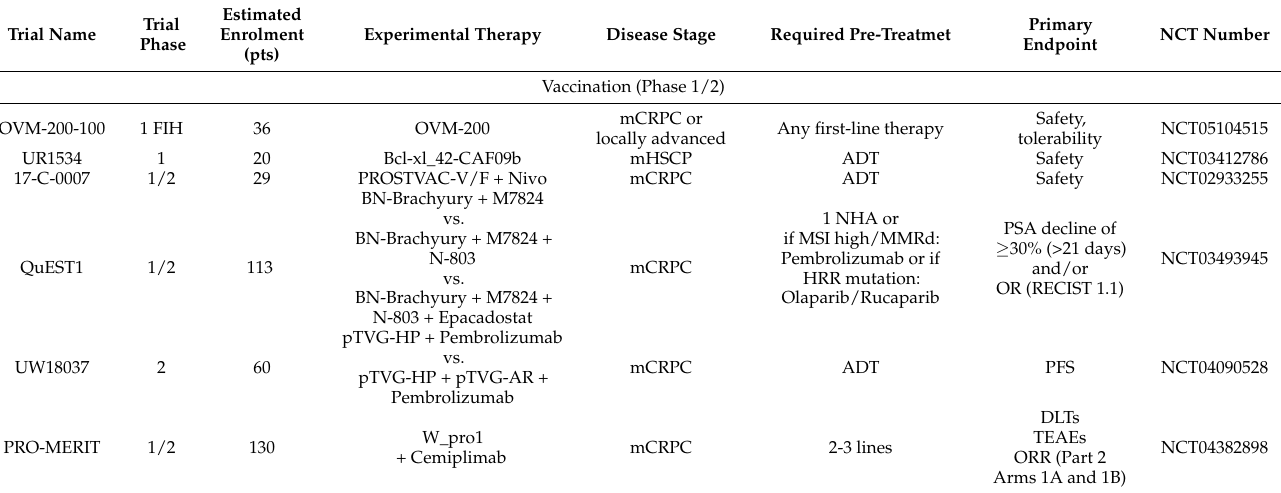
Table 1. Active trials examining vaccination strategies in advanced prostate